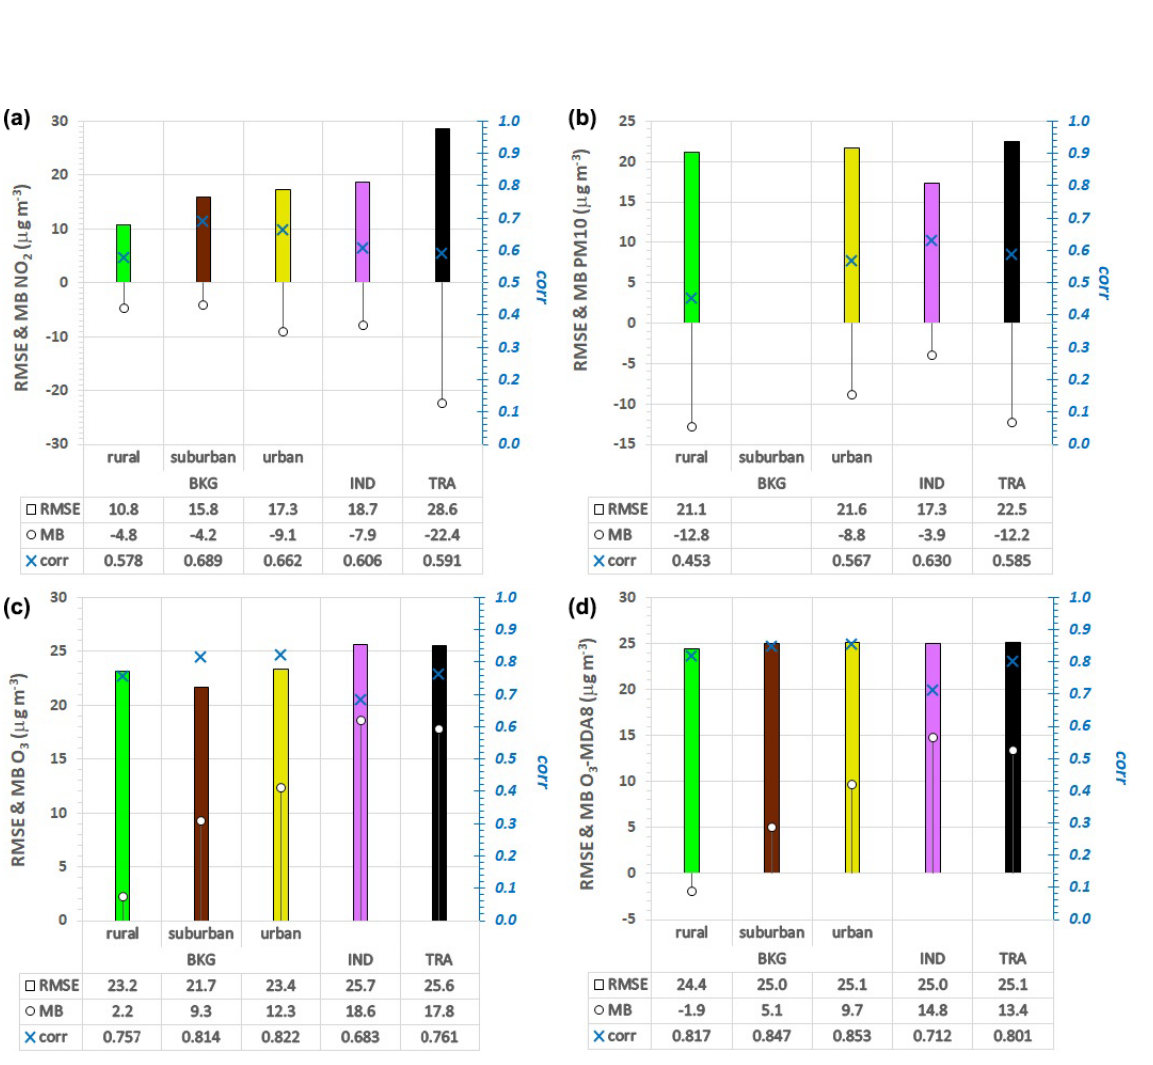
Figure 2. Summary of model performance evaluated at all valid Italian monitoring stations during 2003–2010. The statistical scores are based on annual time series of daily average values of NO 2 (a) , PM 10 (b) , and O 3 (c) and on MDA8 of O 3 , calculated for the period April–September (d)